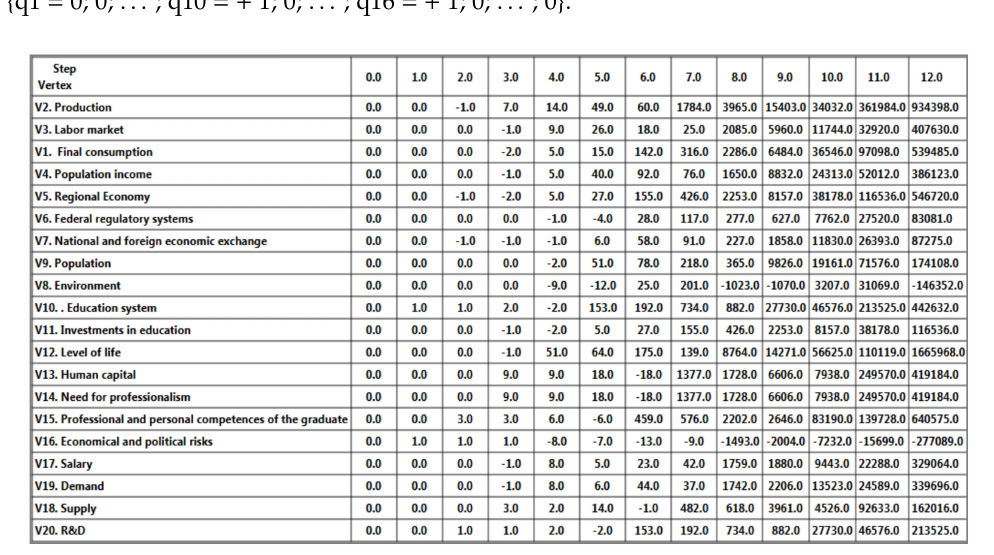
Figure 10. Scenario "Improving the conditions of higher education and economical and political risks increasing" disturbing momentum q10 = + 1 and q16 = + 1 (fragment from the computer data processing results on the program